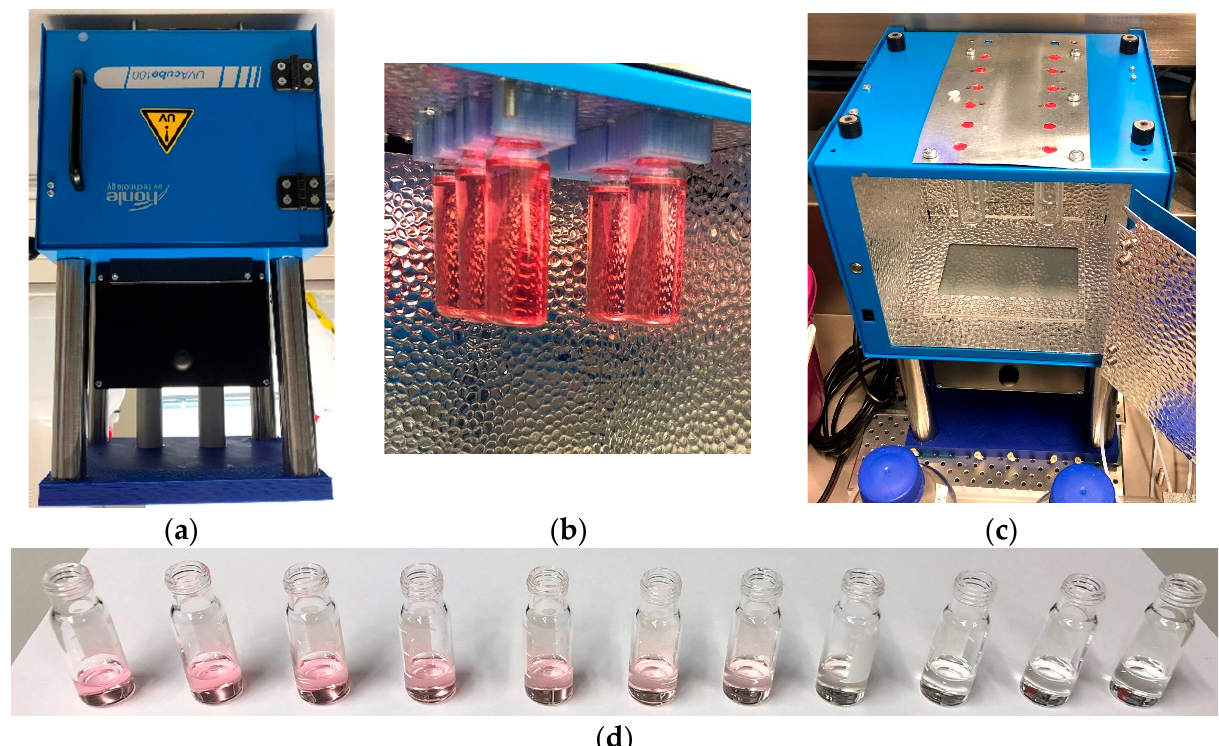
Figure 1. Modified UV chamber and experiments: ( a ) Front view of UV chamber; ( b ) view inside UV chamber with for wells mounted on top filled with P1 dissolved in THF; ( c ) top view of UV chamber implemented in synthesis robot; and ( d ) photometric samples of E1 from ( left ) 0 min to ( right ) 100 min in 10 min intervals.